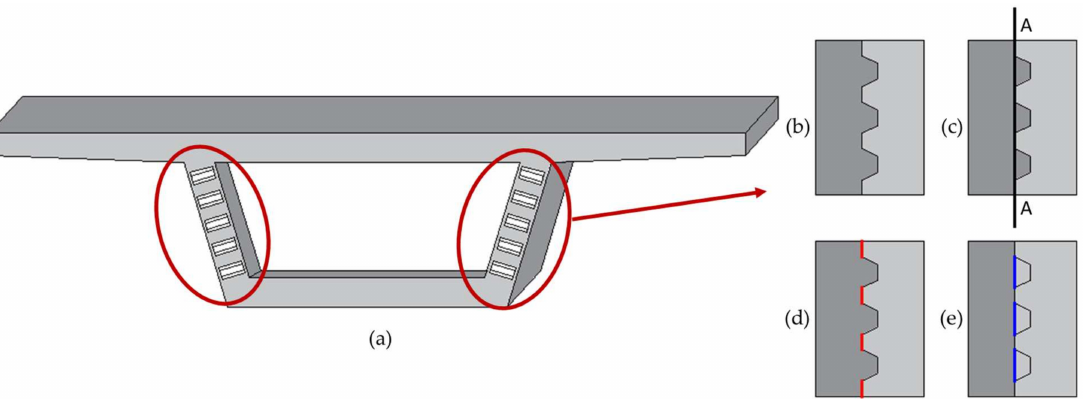
Figure 1. ( a ) Representation of a segmental post-tensioned bridge arch, ( b ) detail of the region of the dry joint of shear key, ( c ) representation of the shear plane, ( d ) representation of the smooth region of the joint and ( e ) representation of the key